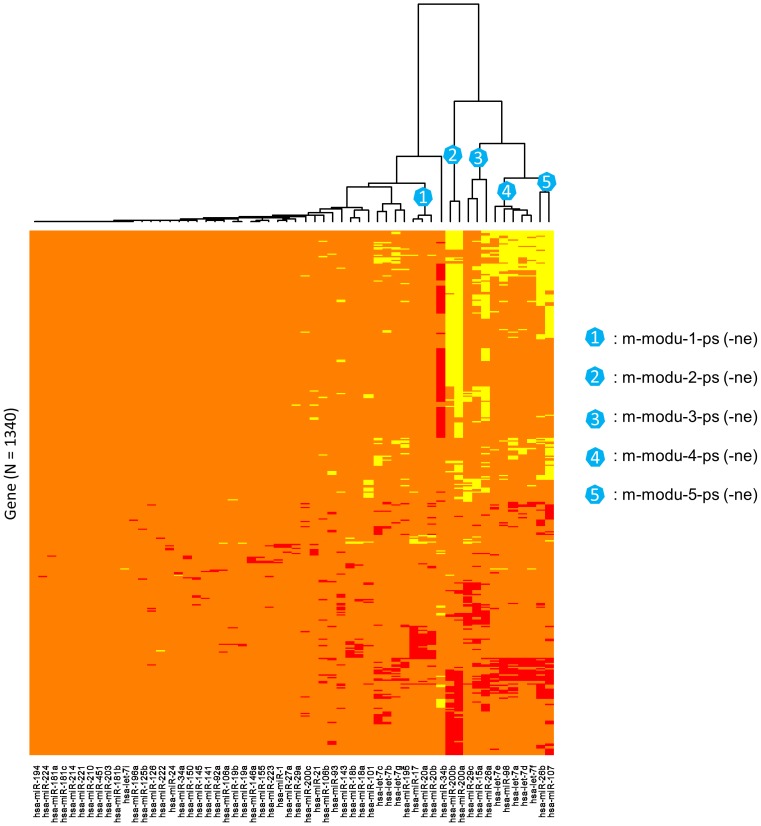
Identifying miRNA-mRNA correlation-network modules in metastatic prostate cancer (MPC) by the hierarchical clustering algorithm.Red: the top 1% positive correlations. Yellow: the top 1% negative correlations. Orange: pseudo or unconsidered correlations.